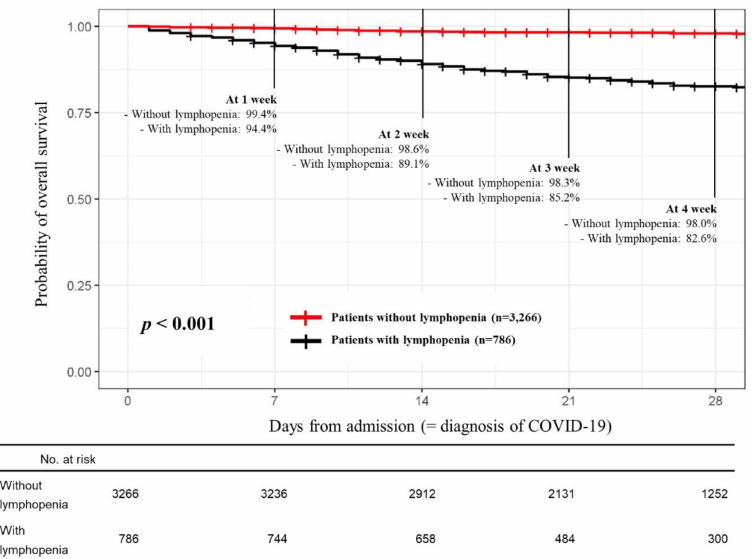
Figure 1. Comparison of the overall survival outcomes of patients with or without lymphopenia